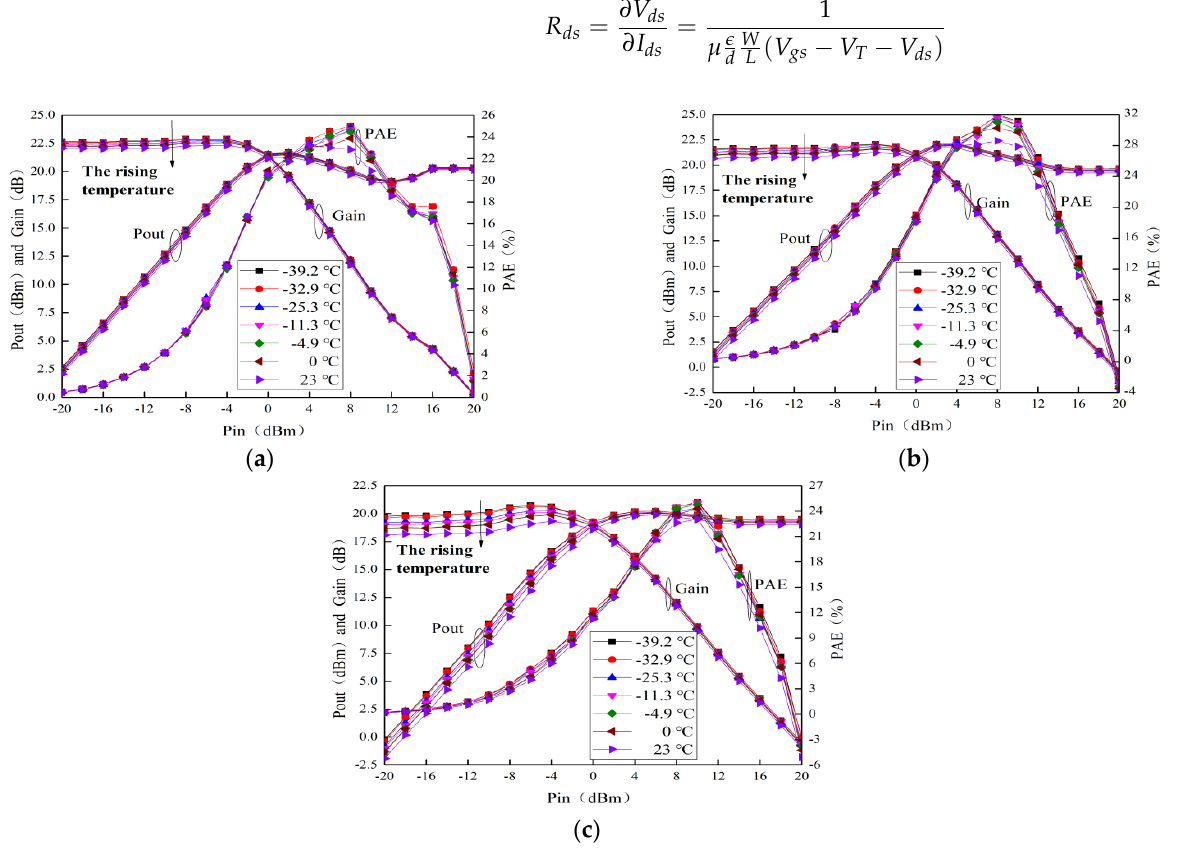
Figure 10. Measured curves of RF output characteristics with typical alpine temperatures. ( a ) 0.4 GHz ( b ) 2.1 GHz ( c ) 3.8 GHz.